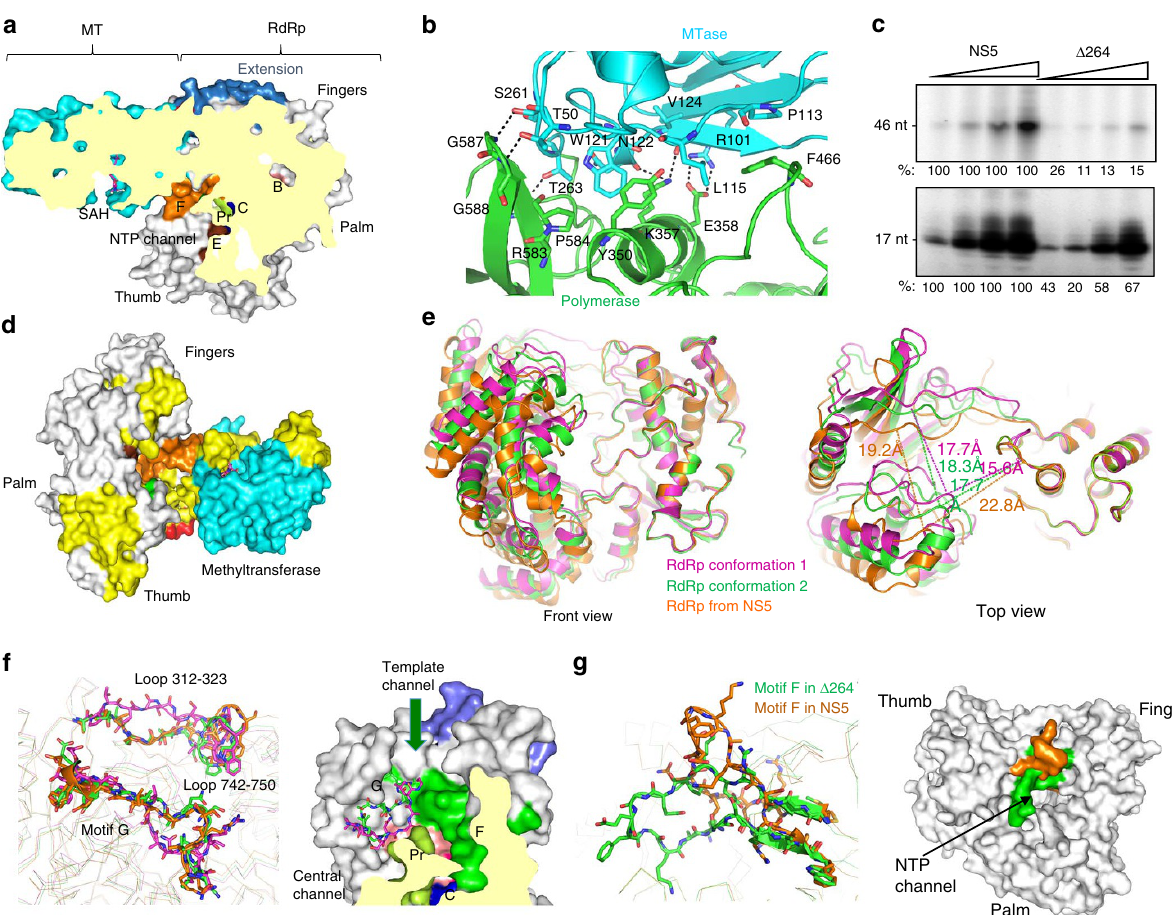
Figure 5 | The MT affects RNA synthesis by the ZIKV RdRp. ( a ) Cut-away surface representation showing the locations of the MT and the RdRp in full-length ZIKV NS5. The MToverhangs the NTP channel and contacts the fingers subdomain of the RdRp. ( b ) Interactions between the MTdomain (cyan) and the fingers subdomain (green). Dashed lines indicate distance o 3.5Å. ( c ) In vitro RNA synthesis catalysed by full-length ZIKV NS5 and D 264 that lacks the MT. Each set of reactions were performed with 5, 20, 100 and 200ng of NS5 protein or D 264 (Supplementary Fig. 6). The PE of 46-nt denotes an elongated product RNA. DN denotes the 17-nt product RNA that initiated de novo with a NTP from the 3 0 -most template nucleotide. The templates used for RNA synthesis are shown in Supplementary Fig. 5. The relative amounts of the products made by D 264 are normalized to those generated by the same concentration of the enzyme in the reaction with NS5. The results shown are reproducible in four independent assays. ( d ) Regions of ZIKV NS5 that contact the template RNA (PE46) for elongative RNA synthesis. Residues from peptides that are reversibly crosslinked to PE46 are shown in yellow. The structure shown is oriented to show the view at the back of the RdRp that connects to the MT. ( e ) Conformational changes of the RdRp in the absence of the MT. Comparison of eight D 264 structures in one asymmetric unit reveals two distinct conformations in loop 312–323 and loop 742–750 located in the back of the RdRp and Motif G. Conformation 2 of D 264 is similar to that in full-length NS5. ( f ) The different conformations of motif F in full-length NS5 (orange) and isolated RdRp ( D 264, green). ( g ) Surface representation showing the different conformations of motif F in full-length NS5 (orange) and isolated RdRp ( D 264,